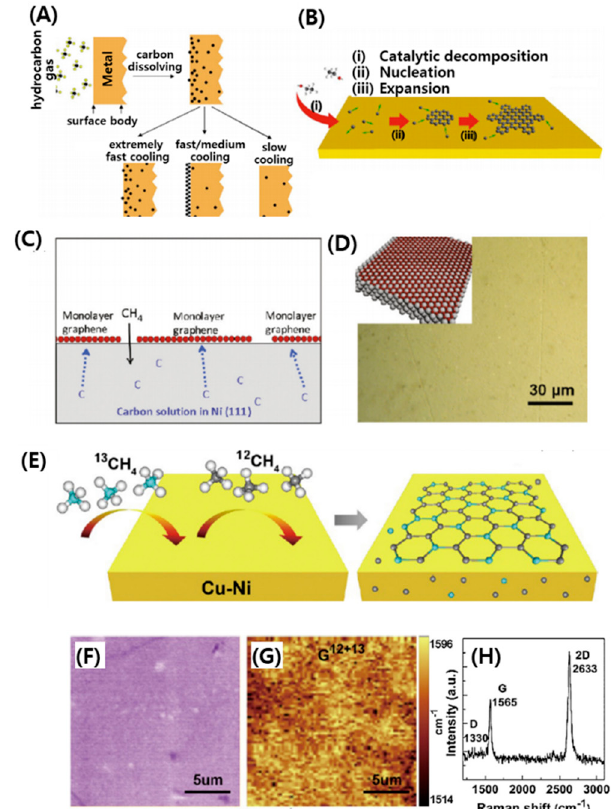
Figure 9. Schematics of CVD graphene grown on ( A ) Ni and ( B ) Cu foil. ( C ) Schematic diagrams of graphene growth mechanism on Ni (111) and ( D ) the optical image of graphene growing on Ni (111) surfaces after the CVD process. ( E ) Schematic diagrams of the growth process of carbon isotope labeled graphene, and the possible distribution of 12 C and 13 C atoms in graphene films and inside the Cu–Ni alloy. ( F ) Optical micrograph of a monolayer graphene transferred onto a 285 nm SiO 2 /Si substrate and ( G ) the corresponding Raman map generated by the position of the G band. ( H ) A Raman spectrum collected from the corresponding monolayer graphene. Reproduced with